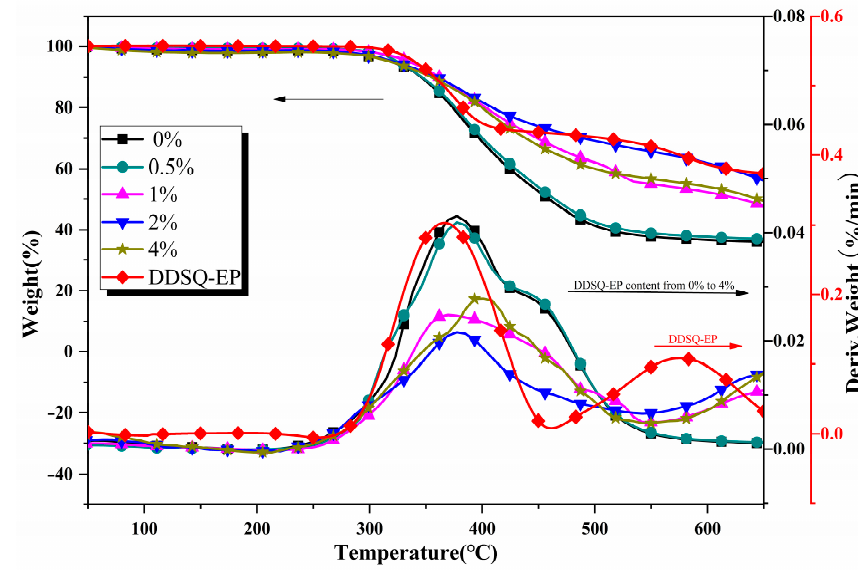
Figure 10. TGA curves of DDSQ-EP and PBZ resins with different DDSQ-EP content.